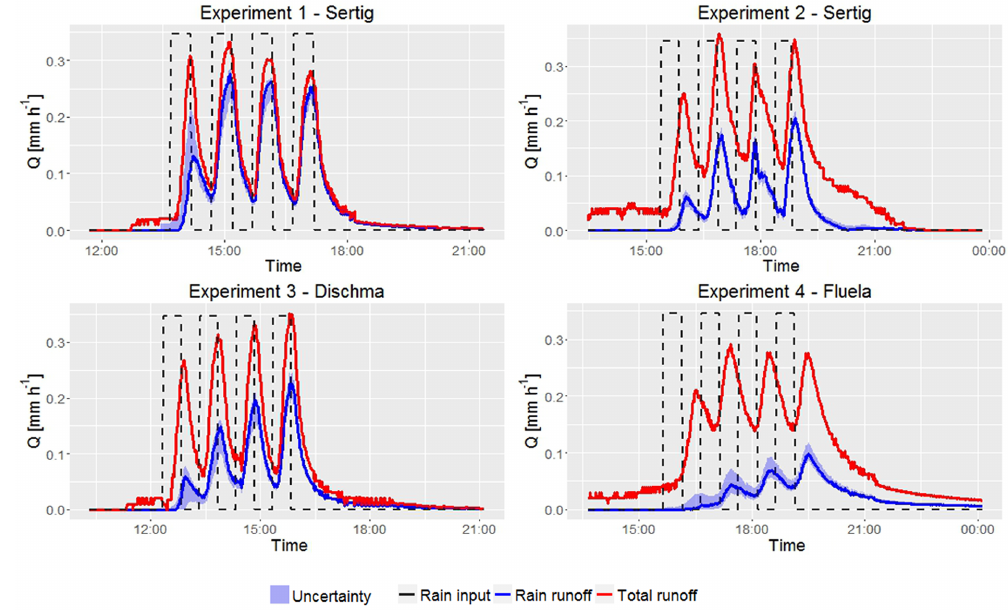
Figure 5. Runoff from the experimental snow block during all sprinkling experiments. X -axis is in resolution of